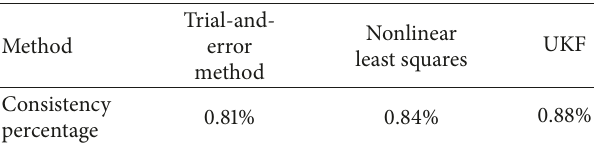
Table 4: Consistency percentage of results based on simulated values of different